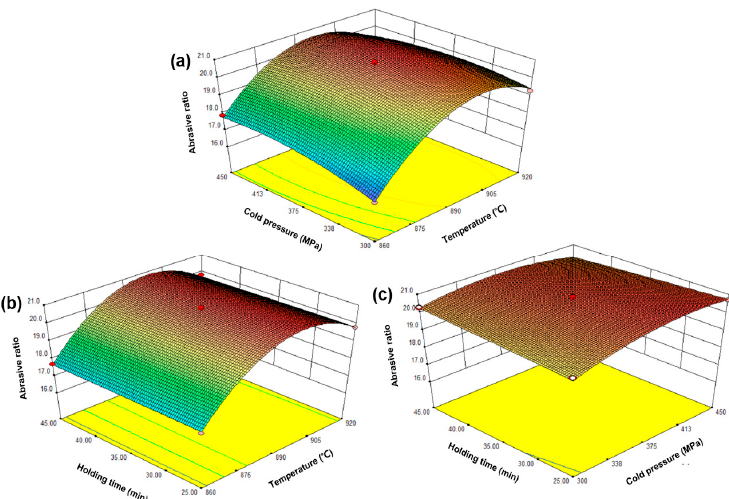
Figure 6. The response surface graph: the effect of sintering temperature, holding time, and cold pressure on the flexural strength of the sintered sample, ( a ) sintering temperature and holding time; ( b ) sintering temperature and cold pressure; ( c ) holding time and cold pressure.